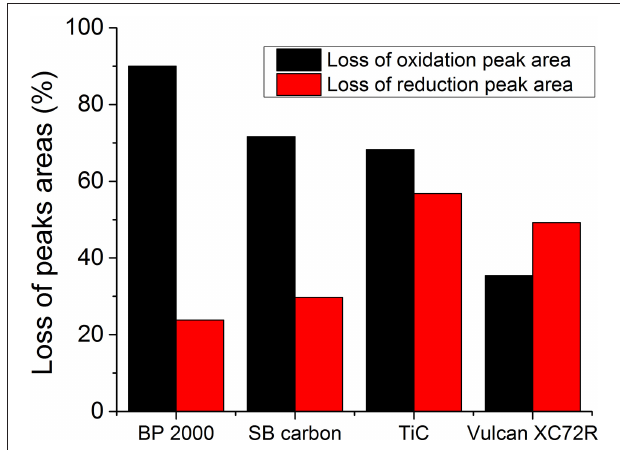
FIGURE 10 | Loss of peak areas of the tested materials, after AST.